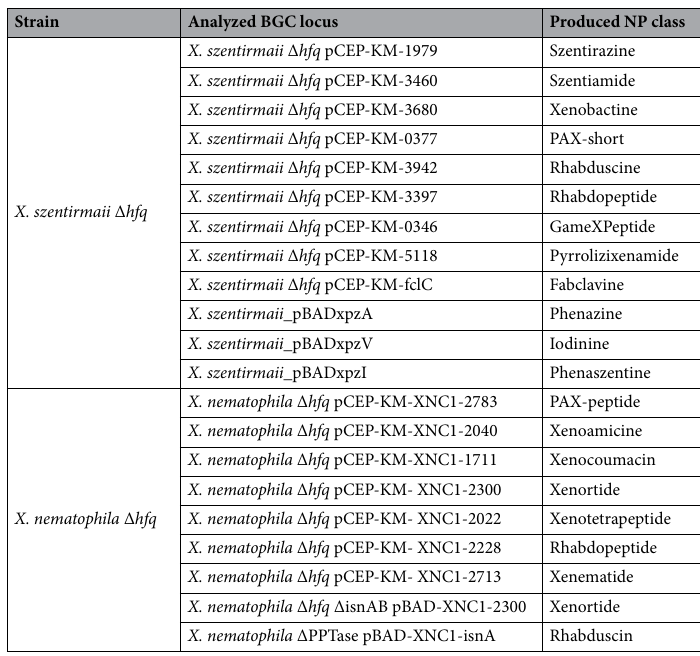
Table 1. Tested Xenorhabdus szentirmaii ∆ hfq and Xenorhabdus nematophila ∆ hfq promotor exchange mutants with the produced compound class of the selected